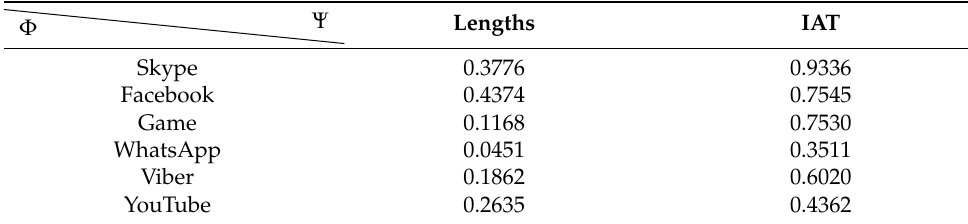
Table 12. Degree of traffic masking